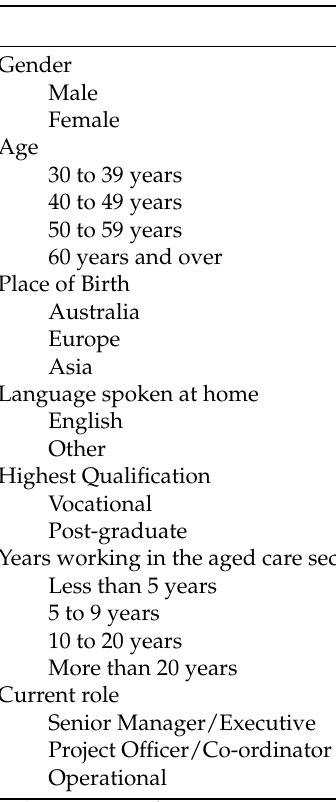
Table 1. Focus Group Participants socio-demographic